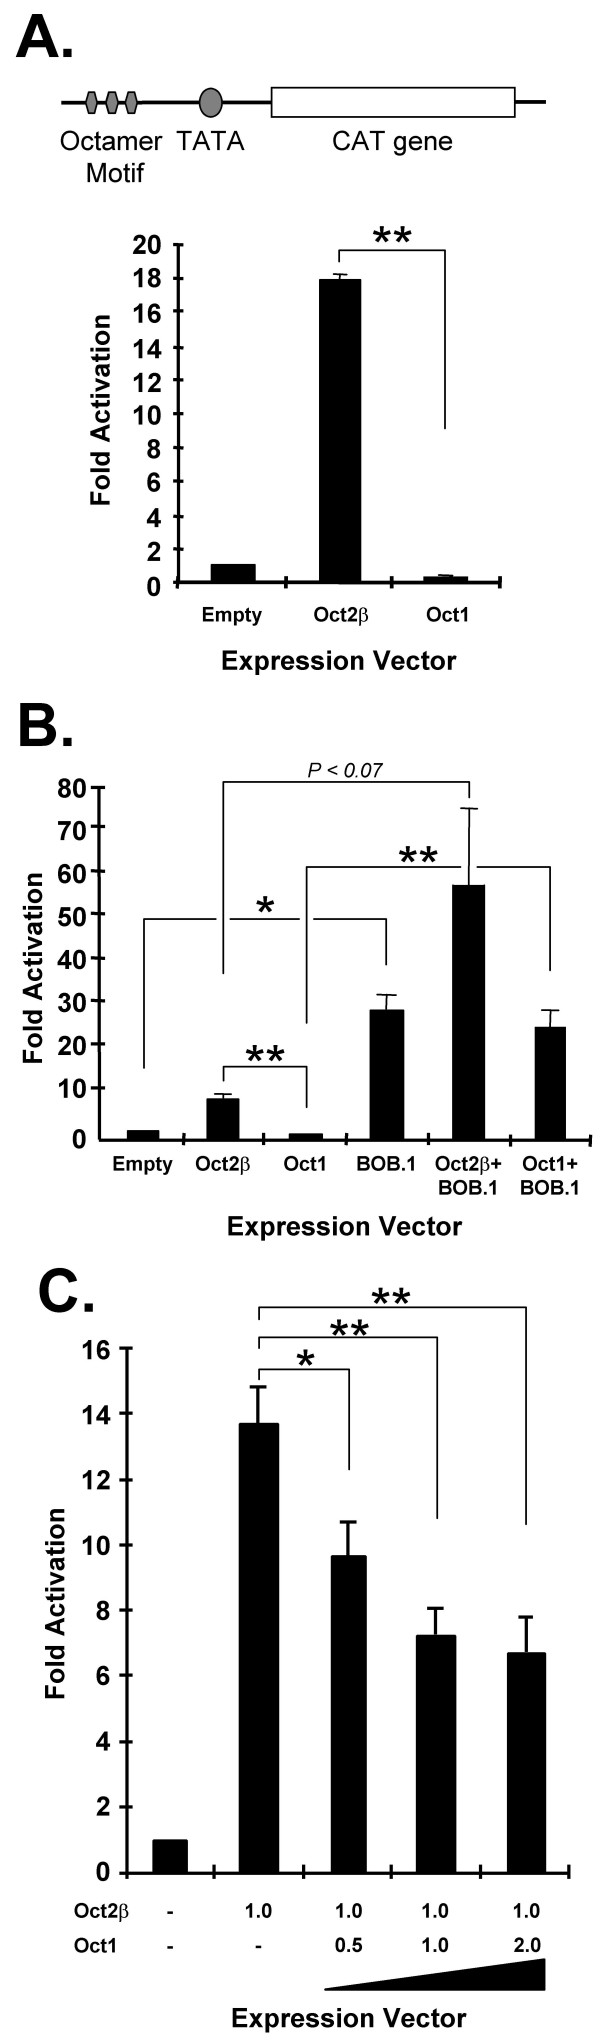
Catfish Oct1 fails to drive transcription from an octamer-dependent reporter construct. A schematic representation of the reporter construct (pO3-Δ56-CAT [31]) containing an octamer trimer is shown in A. The octamer motifs are shown upstream of the TATA box (from the minimal c-fos promoter) and the CAT reporter gene is shown as an open box. Transcriptional activation (as fold increase) was measured following co-transfection into the catfish B cell line (1G8) of the reporter construct and an Oct expression construct. A. Transcriptional activation driven by catfish Oct2β (pRc/CMV/Oct2β) or catfish Oct1 (pRc/CMV/Oct1). B. Transcriptional activation driven by catfish Oct2β (pRc/CMV/Oct2β), catfish Oct1 (pRc/CMV/Oct1) and human BOB.1 (pRc/CMV/hBOB.1), or by a co-transfection of catfish Oct2β with human BOB.1, or catfish Oct1 with human BOB.1. C. Negative transcriptional regulation by catfish Oct1. One pM of catfish Oct2β expression construct was co-transfected with increasing amounts of catfish Oct1 (0.5, 1.0, 2.0 pM respectively) and the transcriptional activation of the reporter construct measured. Values for five replicate transfections in A and four replicate transfections in B and C are shown as mean ± SEM. Statistical significance was calculated by the Student T test assuming unequal variances. One asterisk indicates a p value of less than .05 and two asterisks indicates a p value of less than .01.